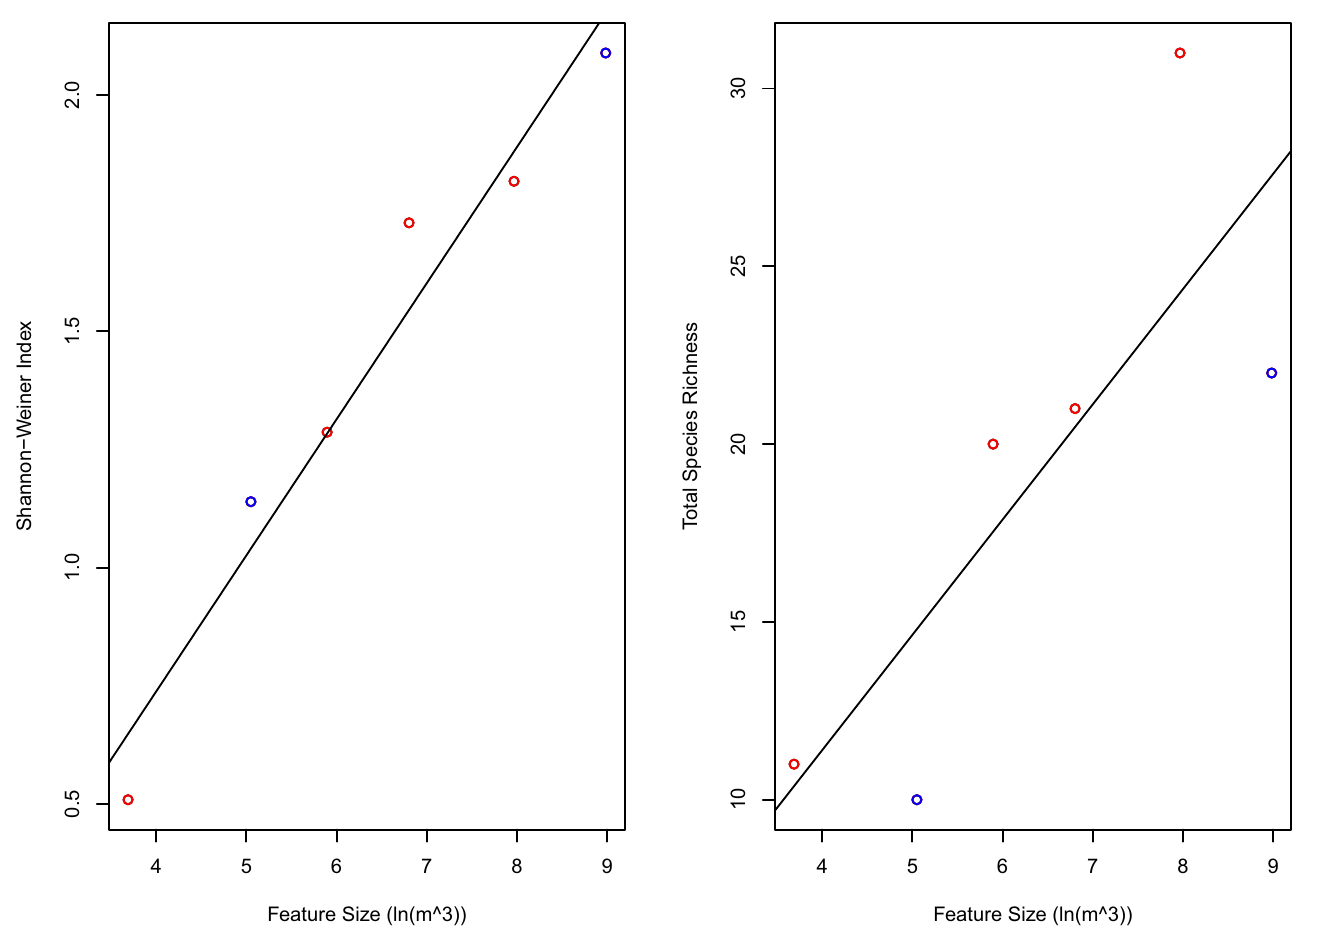
Fig 2. Alpha diversity vs. logarithm of volume and depth. Shannon-Weiner Index (A) and Species Richness (B) are plotted against logarithm of volume. To illustrate the effects of depth, features between 90–120 m are marked in red, and features between 135–185 m are marked in blue.